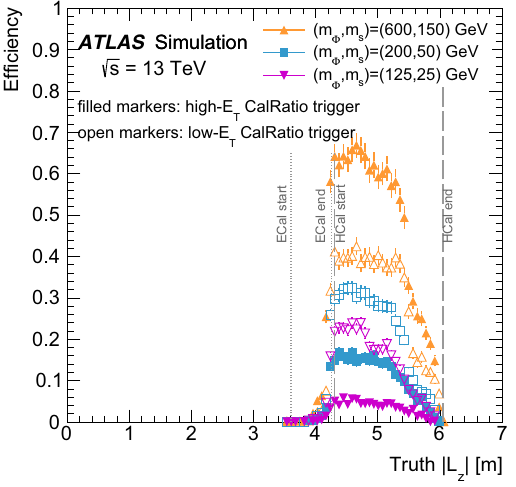
endcaps (right, 1 . 4 ≤ | η | < 2 . 5) for three signal samples. The open (filled) markers represent the efficiency for events passing the low- E T (high- E T ) CalRatio